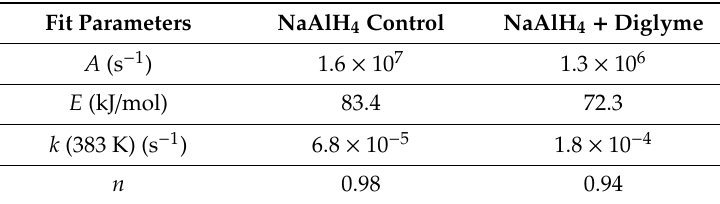
Figure 2. Fractional decomposition from step 1 for ( a ) NaAlH 4 control and ( b ) NaAlH 4 + diglyme. Table 1. Fit parameters A , E , and n from the A-E fit to the first step of desorption (fractional decomposition) of NaAlH 4 (control) and NaAlH 4 + diglyme.